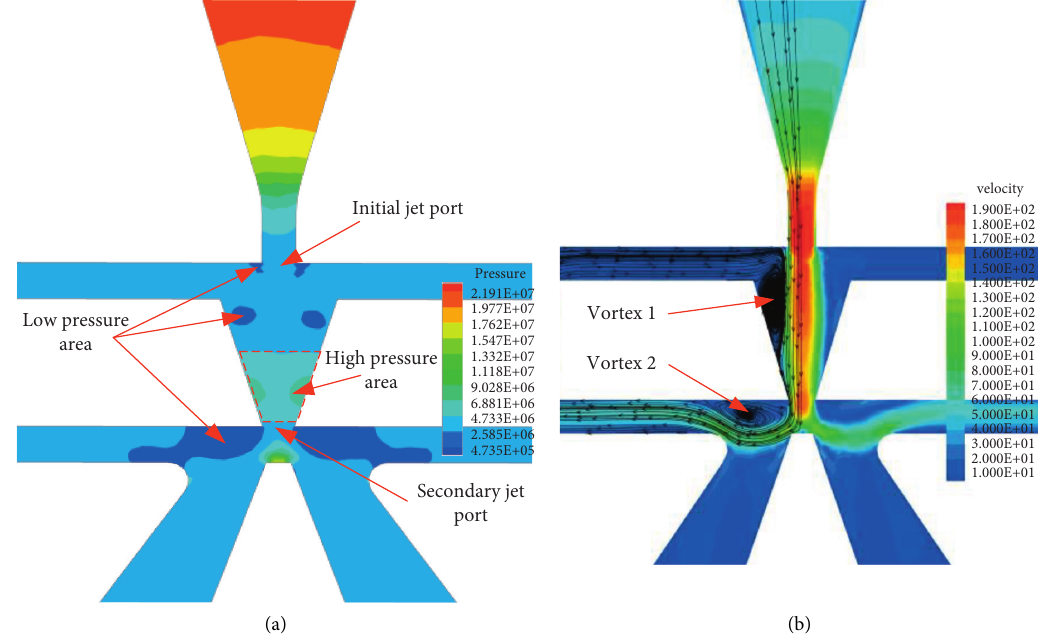
Figure 10: Pressure and velocity distributions. (a) Internal pressure contours. (b) Internal velocity contours.